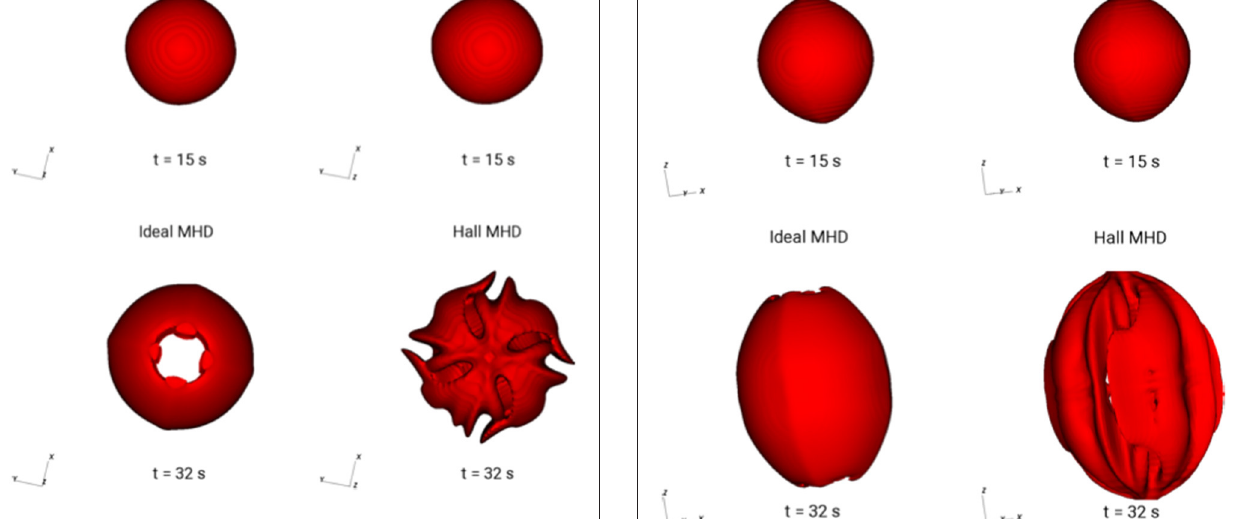
FIGURE 8 | Isodensity contours of the expanding ion cloud viewed along the magnetic field at times t = 15 and 32s for the ideal and Hall MHD cases. ions have m d /m e = 100, initial cloud density n d / n o = 25, initial radius = 2 c/ ω pe , expansion velocity v d = v A , ω pe / ω ce = 5. The system size is 25 × 25 c/ ω pe in 2-D, using 5 million simulation particles to represent the debris ions and electrons and 25 million particles each to present the background ions and electrons.